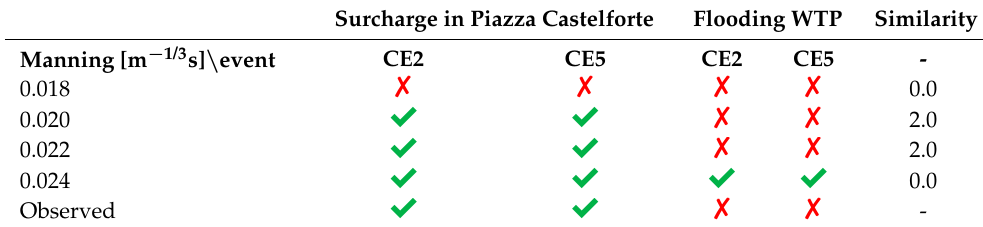
Table 2. Calibration similarity matrix.